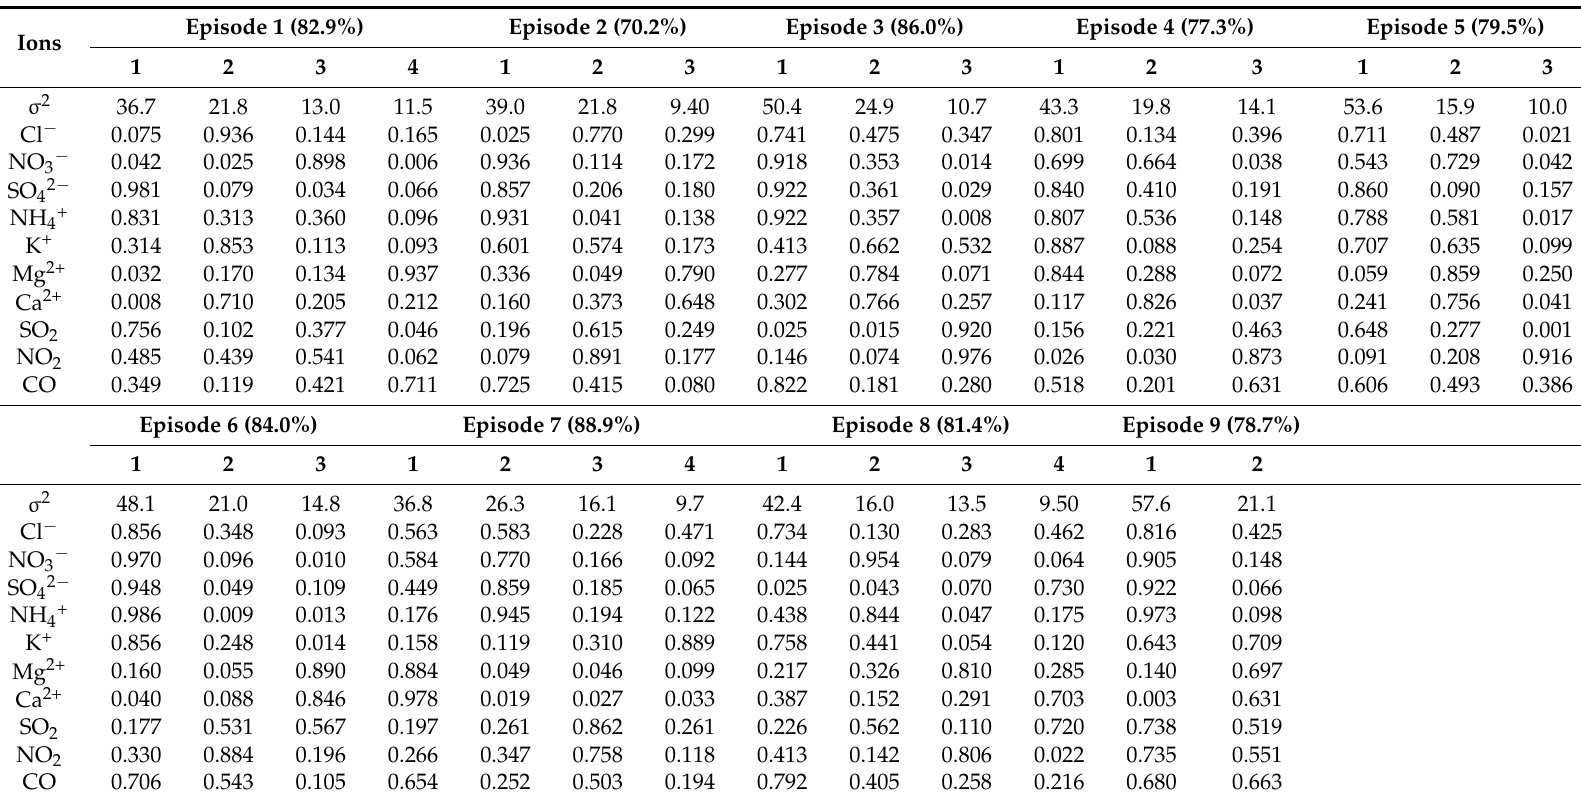
Table 4. Principal component analysis (PCA) results for water-soluble ions in PM 2.5 , SO 2 , NO 2 , and